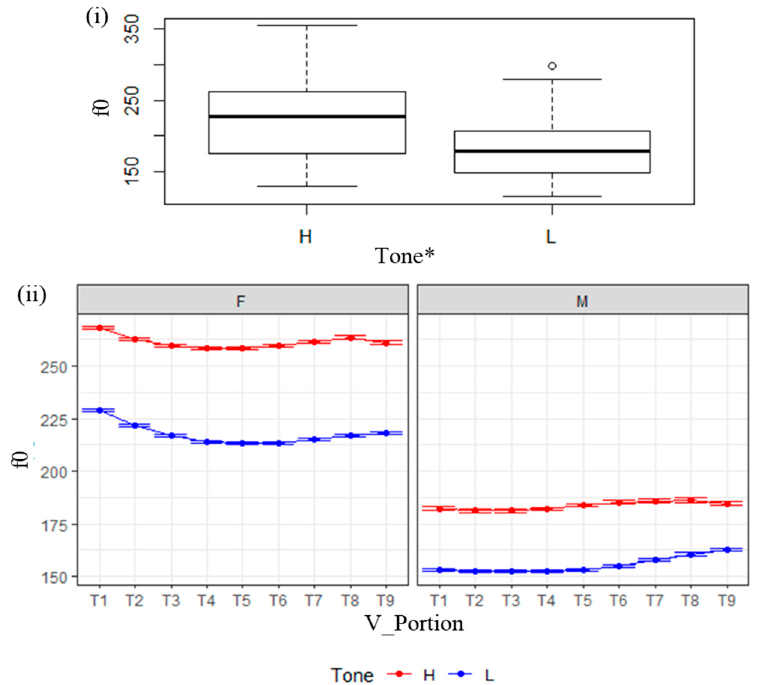
Figure 2. ( i ) Box plot representing the mean f0 shows a significant difference in terms of tone types (viz., high and low) (indicated with an asterisk in the tone). ( ii ) The f0 values averaged across nine timepoints (shown as T1, T2, … T9) show that the high tone is generated following the loss of the feature (+spread glottis) shown in Table 1. F = female, and M = male.